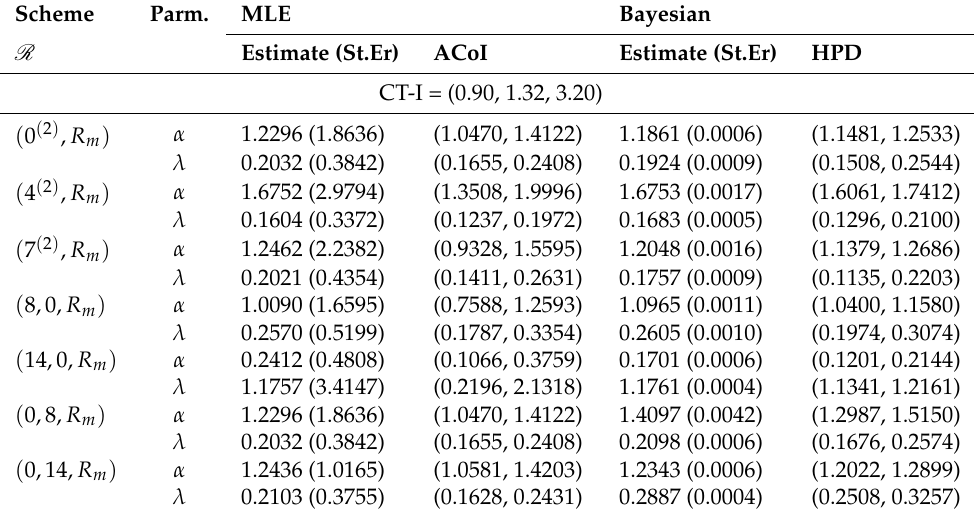
Table 8. ML and BEs with associated St.Er (in practices) and CoIs based on various PT1C schemes for given real data set at m =